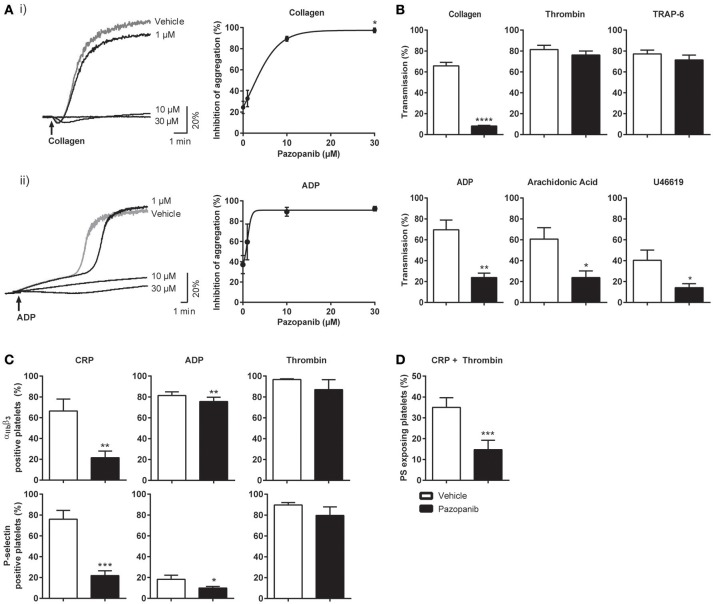
Pazopanib inhibits collagen- and ADP-induced platelet aggregation, integrin activation, secretion and PS exposure. Washed platelets from healthy donors were incubated with 1, 10, or 30 μM pazopanib or vehicle (0.1% DMSO) for 10 min. (A) Representative aggregation curves and dose-response graphs of inhibition of aggregation (n = 4). Arrow indicates addition of (i) 1 μg/mL collagen or (ii) 25 μg/mL fibrinogen and 1 μM Me-S-ADP. (B) Aggregation of washed platelets in presence (black bars) or absence (white bars) of 10 μM pazopanib was induced by 1 μg/mL collagen, 1 nM thrombin, 10 μM TRAP-6, 1 μM Me-S-ADP in presence of 25 μg/mL fibrinogen, 30 μM arachidonic acid or 1 μM U46619. Histograms indicate maximal amplitude of aggregation (n = 6). (C) Platelets, pre-treated with vehicle or pazopanib (10 μM), were stimulated with 5 μg/mL CRP-XL, 1 μM Me-S-ADP or 1 nM thrombin for 10–20 min, and analyzed by flow cytometry (n = 6). Shown are percentages of platelets binding FITC-labeled PAC-1 monoclonal antibody against integrin αIIbβ3 or FITC-labeled anti-human CD62 mAb. (D) Platelets pre-treated with vehicle or pazopanib (10 μM) were stimulated with 5 μg/mL CRP-XL and 4 nM thrombin for 60 min, and analyzed by flow cytometry (n = 6). Exposure of PS was determined by FITC-labeled annexin A5. Histogram shows percentages of platelets binding FITC-annexin A5. Data are means ± SEM, *p < 0.05, **p < 0.01, ***p < 0.001, ****p < 0.0001.